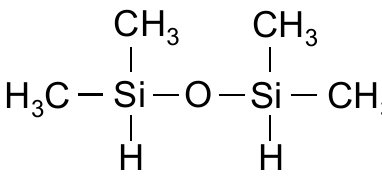
Figure 3. Structure of TMDSO.